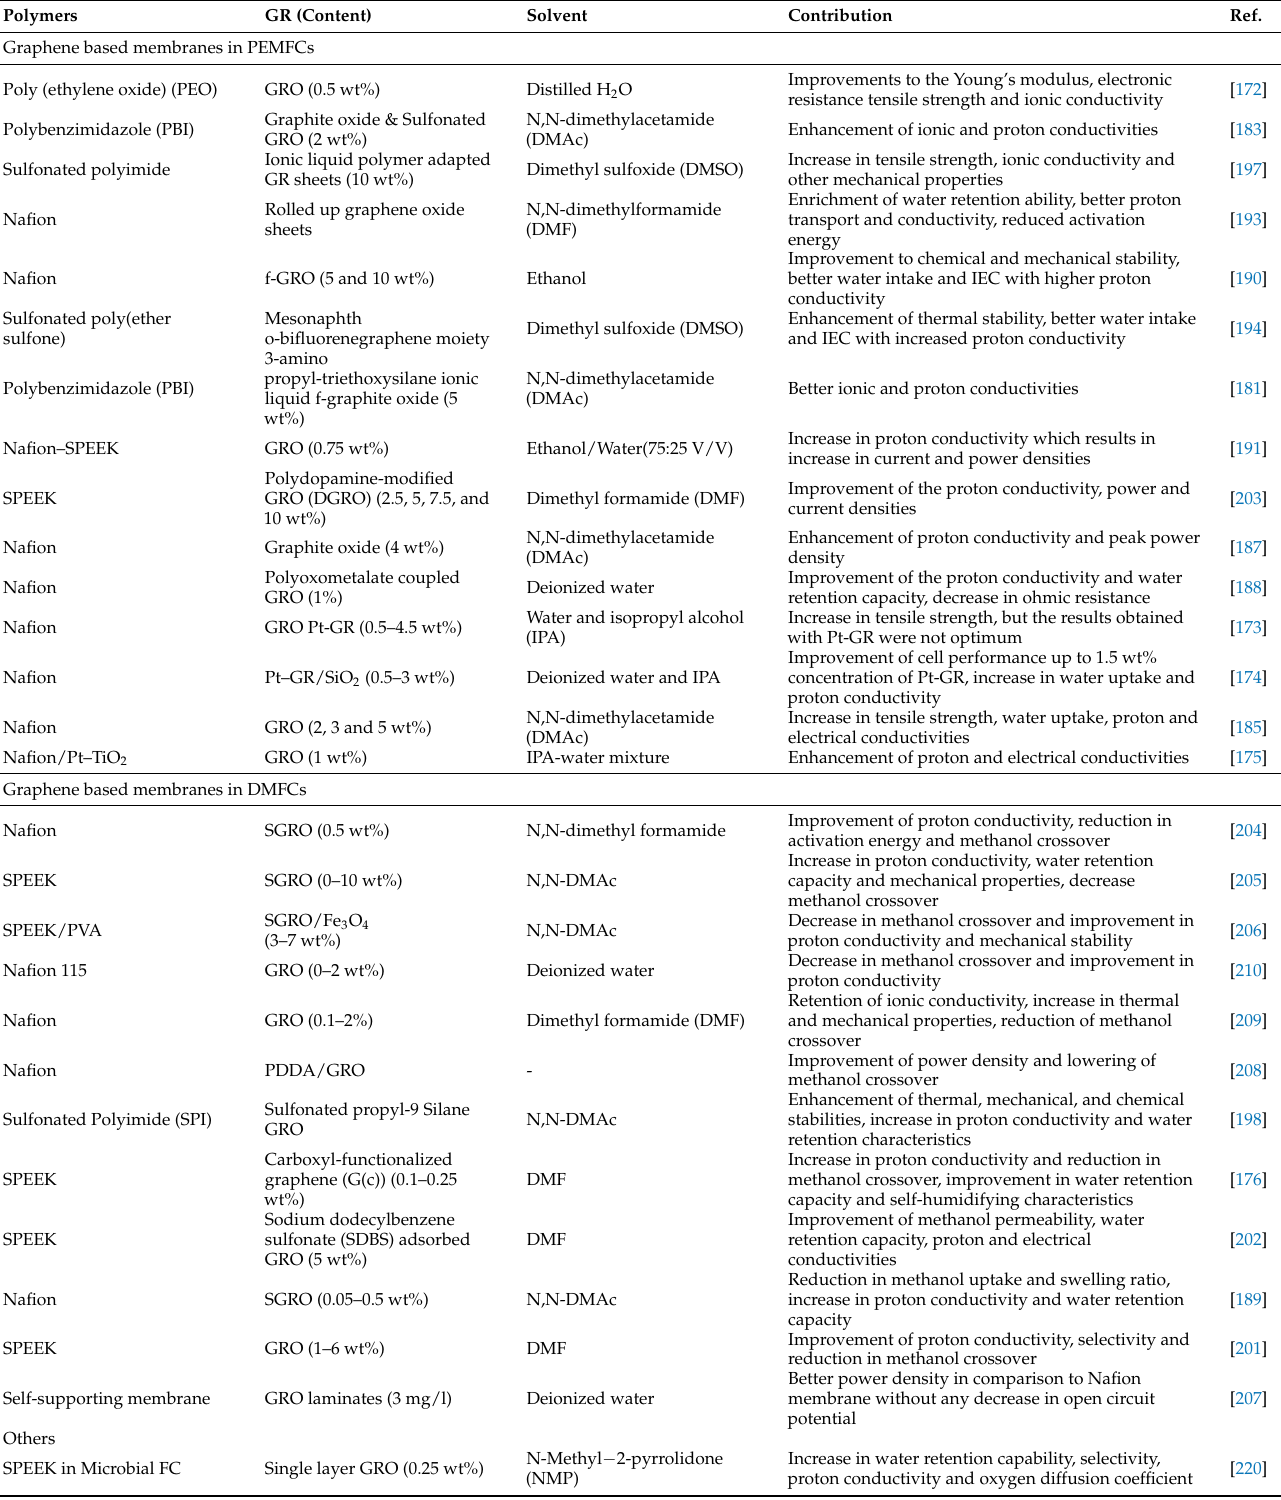
Table 5. GR based membranes in fuel